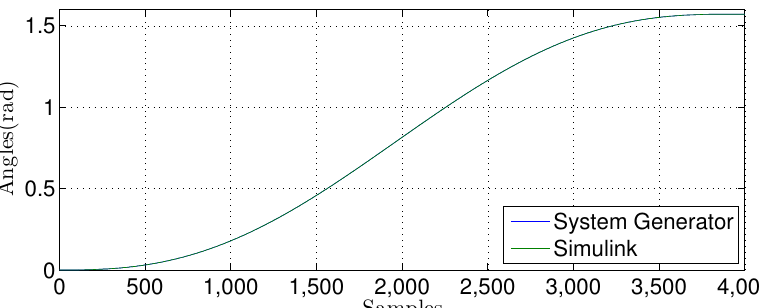
Figure 30. Comparison of the simulation results in Matlab Simulink and system generator for the linear regression technique with M = 9.